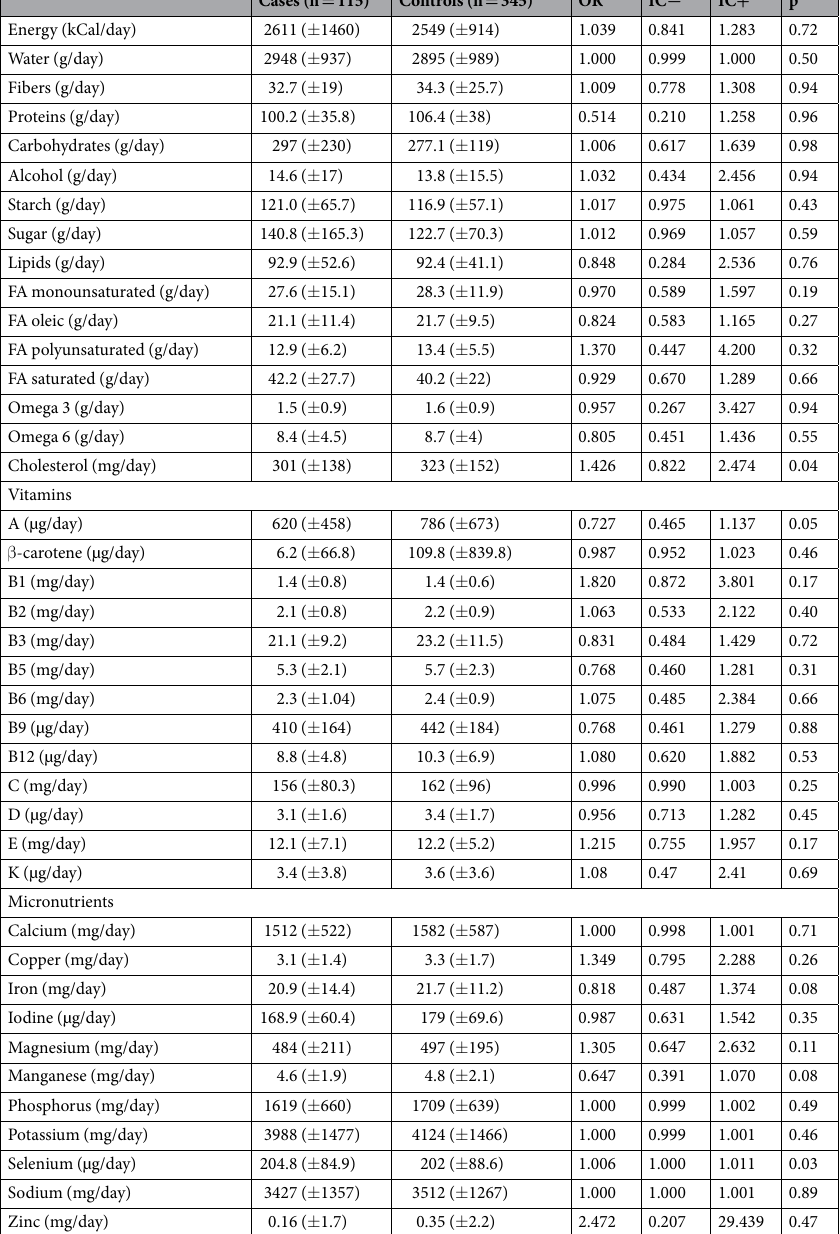
Table 1. Nutrition patterns in EMAP patients and controls. FA: fatty acids. The data (OR, IC, p-value) represents univariate analysis results. None of the nutrients was significant under multivariate conditional logistic